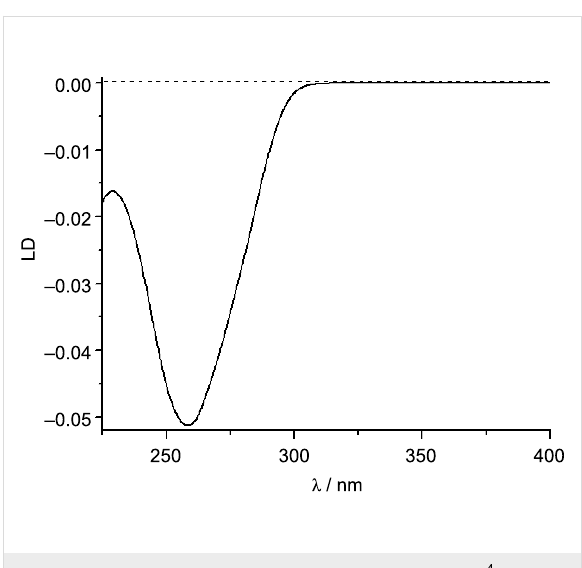
Figure 10: LD spectrum of calf thymus ( ct) DNA ( c = 2 × 10 − 4 M), pH 7, sodium cacodylate buffer, I = 0.05 M.